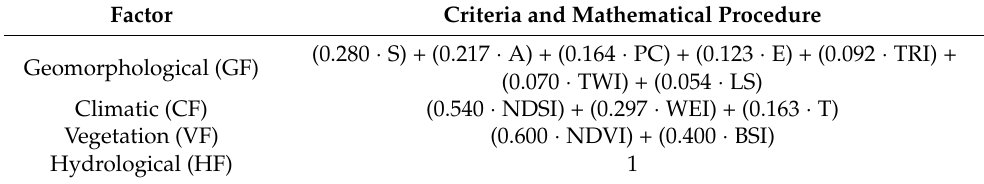
Table 12. Calculation of weight